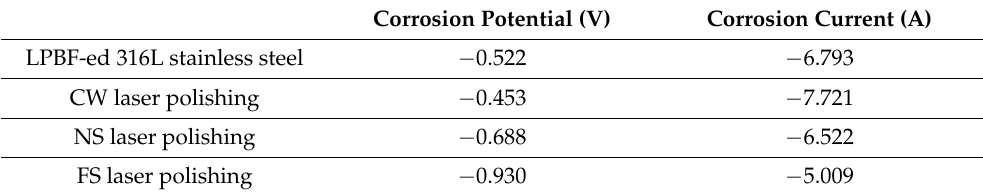
Table A2. Quantitative information of SS samples before and after laser polishing.